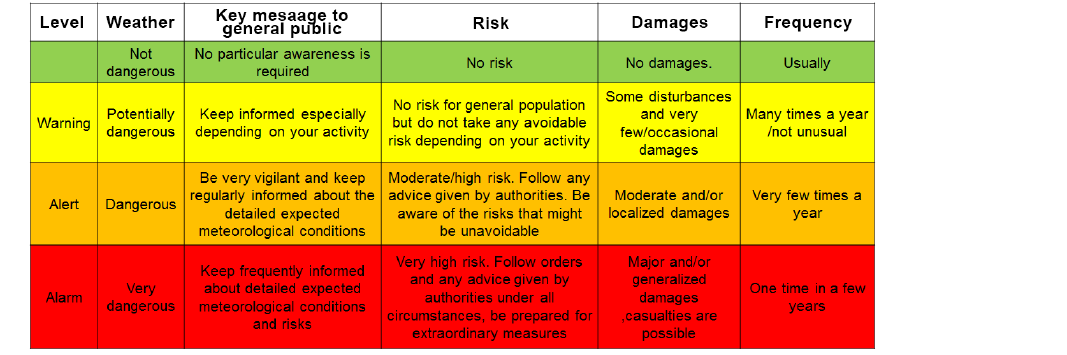
Figure 1. General considerations depending on warning level.